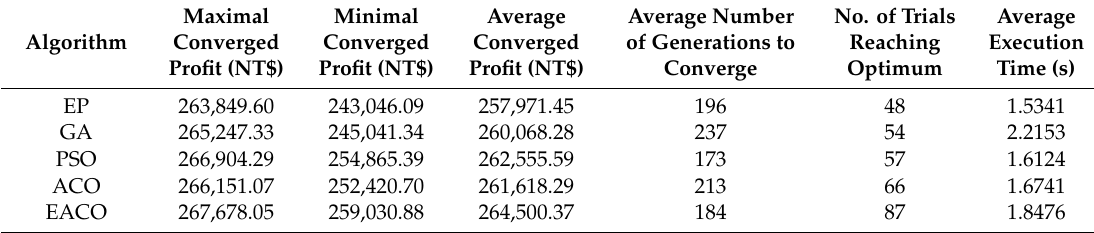
Table 9. Robustness test for EP, GA, PSO, ACO, and EACO algorithms in a peak period.